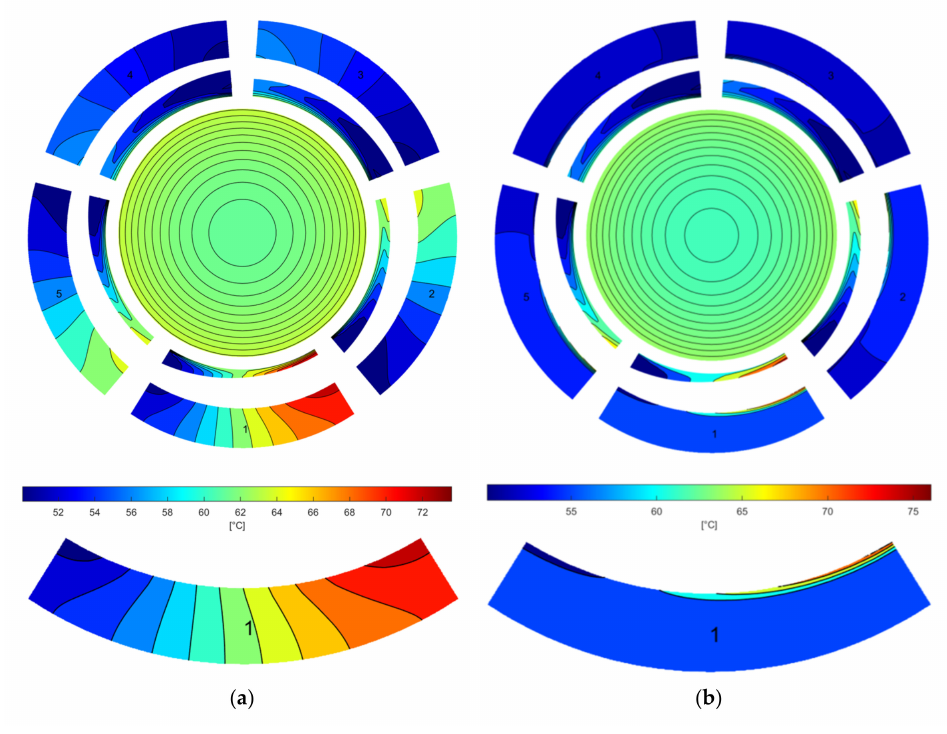
Figure 4. Temperature distribution in nominal conditions: ( a ) Babbitt lining and ( b ) PEEK lining.